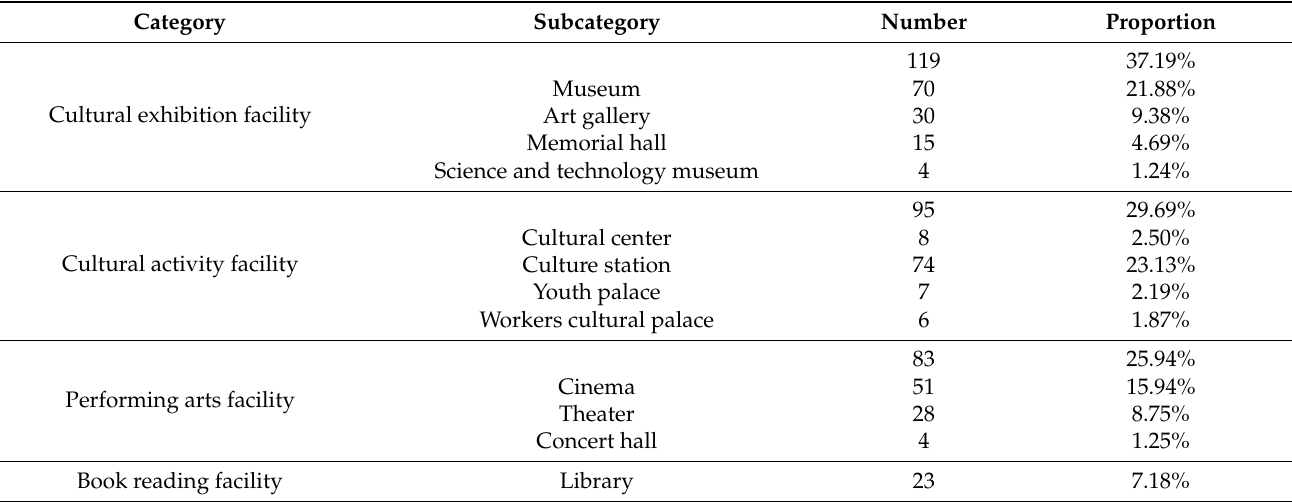
Table 2. The composition of cultural facilities in the central district of Ningbo in